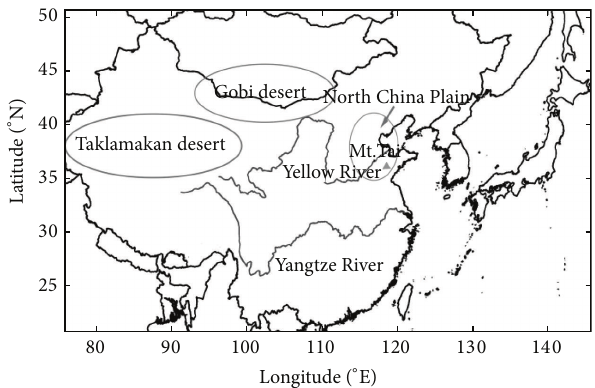
Figure 1: Model domain, location of Mt. Tai, and major